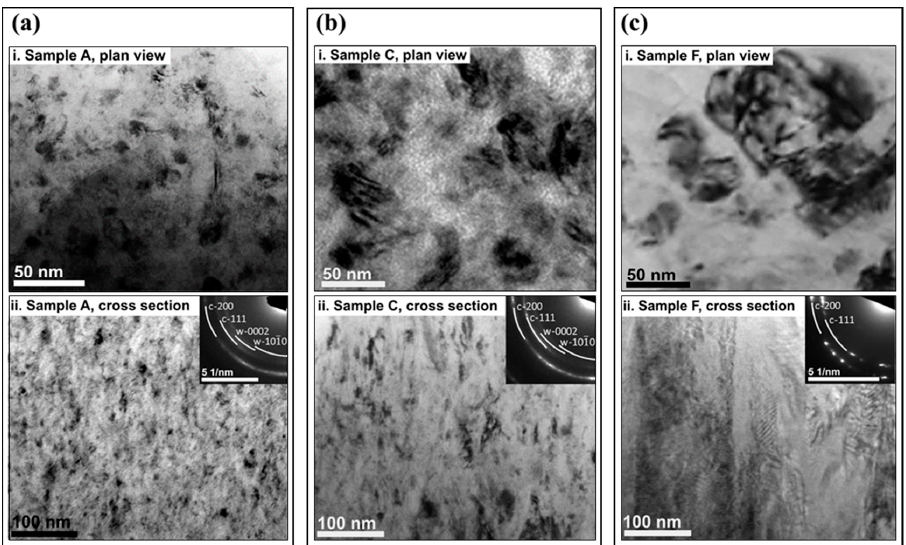
Figure 8. TEM micrographs of plan view ( i ), cross-section ( ii ) and selected area diffraction pattern (SAEDP) inset of as-deposited coatings A ( a ), C ( b ), and F ( c ), respectively. The SAEDPs of coatings A ( a ) and C ( b ) are indexed with mixed B1 and B4 phases, whereas the SAEDP of coating F ( c ) with a single phase B1 structure.